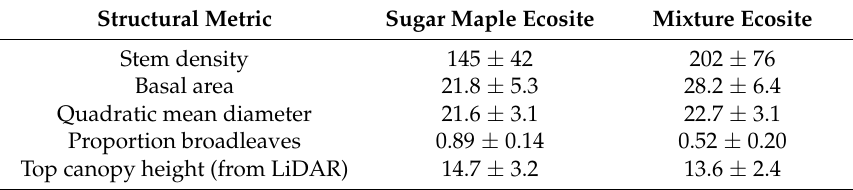
Table 1. Mean ( ± s.d.) values for stand structural attributes across the set of calibration